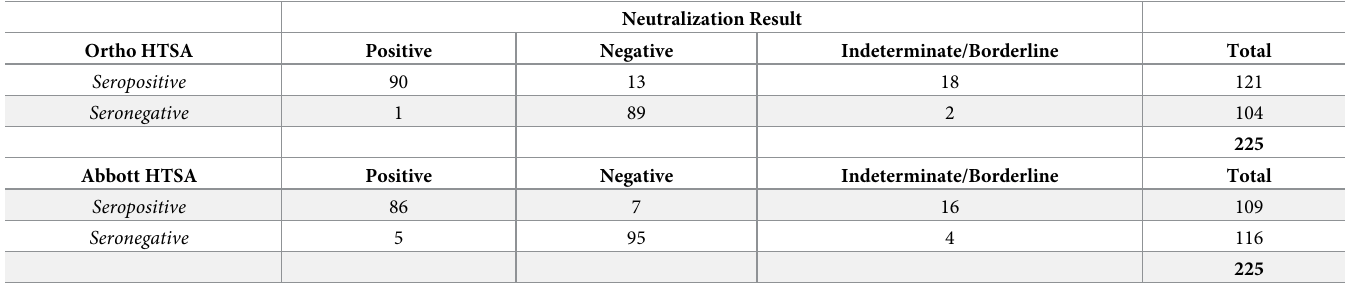
Table 2. Correlation of serological results with neutralization